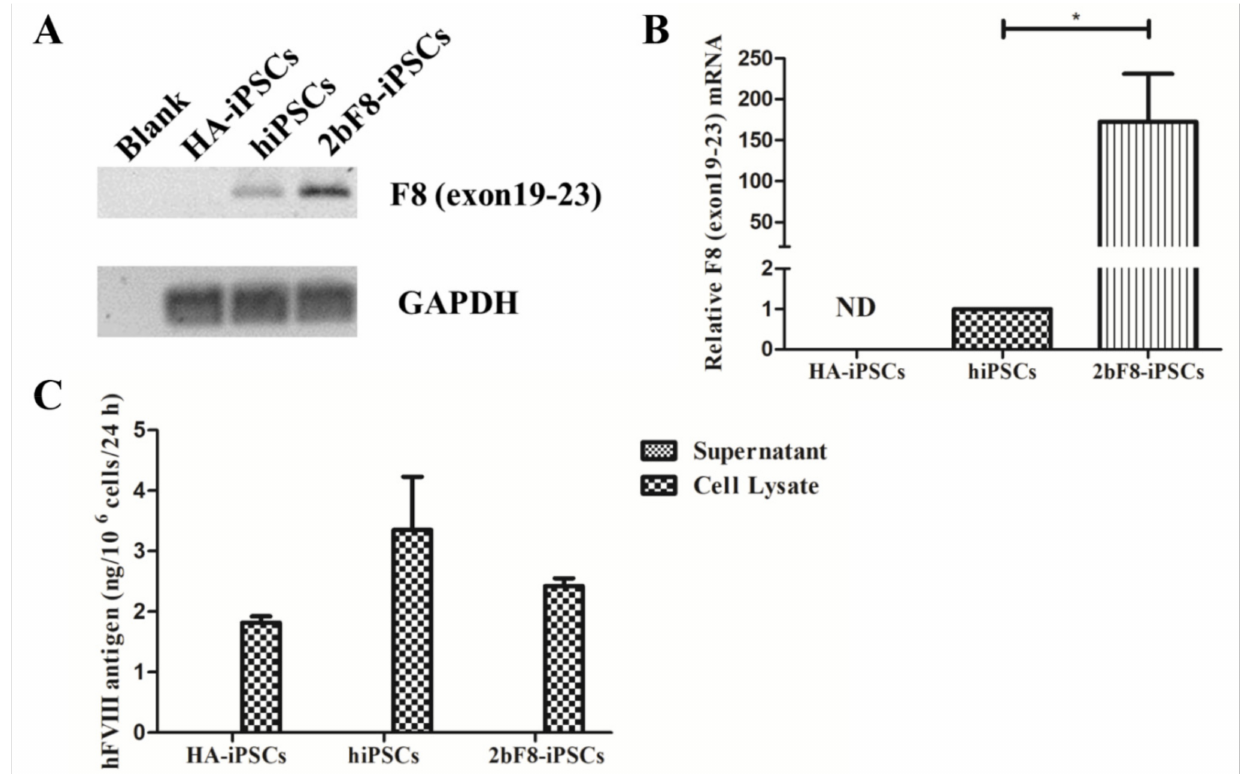
Figure 3. Verification of F8 expression in F8 -modified hiPSCs. ( A ) The mRNA of F8 genes from HA- iPSCs, hiPSCs, and 2bF8-iPSCs were detected by RT-PCR. ( B ) Relative expression of F8 in HA-iPSCs, hiPSCs, and 2bF8-iPSCs was detected by qRT-PCR. GAPDH was used as the internal reference. ND, not detected. * p < 0.05. Bars represent the mean ± SEM ( n = 3, each group). ( C ) ELISA detection of the FVIII antigen in the supernatant and cell lysate of HA-iPSCs, hiPSCs, and 2bF8-iPSCs. Data represent the mean ± SEM ( n = 3, independent